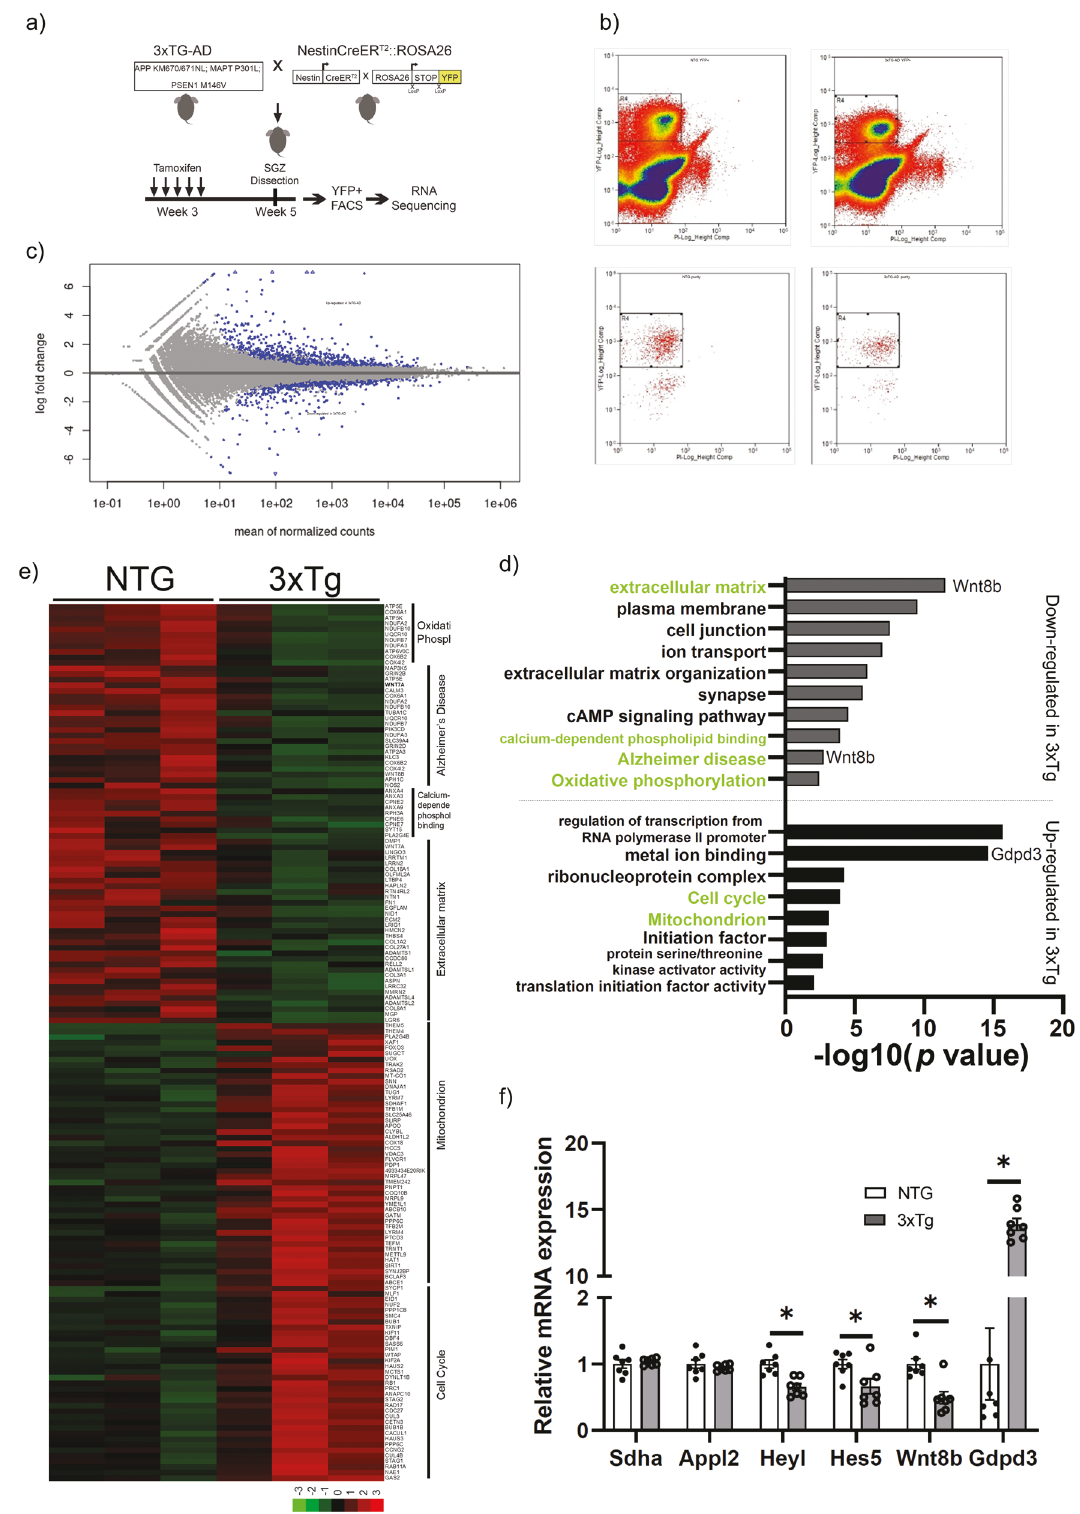
Fig. 5 Early transcriptional changes in the SGZ of 3xTg at 1 month of age. a Methodology. b Cell sorting strategy of neural stem/progenitor cells using Nestin-YFP. c MA plot of RNA-seq. Signi fi cant genes are labelled in Blue with 1391 signi fi cant genes, 720 genes as down-regulated and 671 as up-regulated in the 3xTg cells. n = 3. d Gene ontology (GO) analysis of genes shown in c , up- or down- regulated respectively. e Heatmap showing the expression pattern of signi fi cantly altered genes grouped under different GO terms: Oxidative phosphorylation, mitochondrion, cell cycle, Alzheimer disease, calcium signaling, and extracellular matrix. Color density indicates the z-score computed from the normalized read counts. f RT-PCR validation of selected genes. Data represented as mean ± SEM. Statistical analysis was performed with an unpaired two-tailed Student ’ s t -test, p < 0.05*. n = 7.